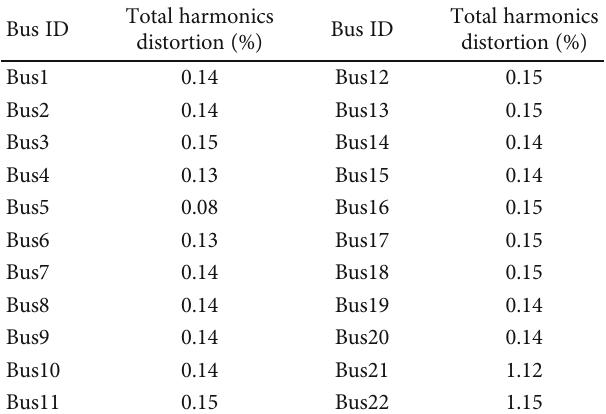
Table 16: System harmonics bus